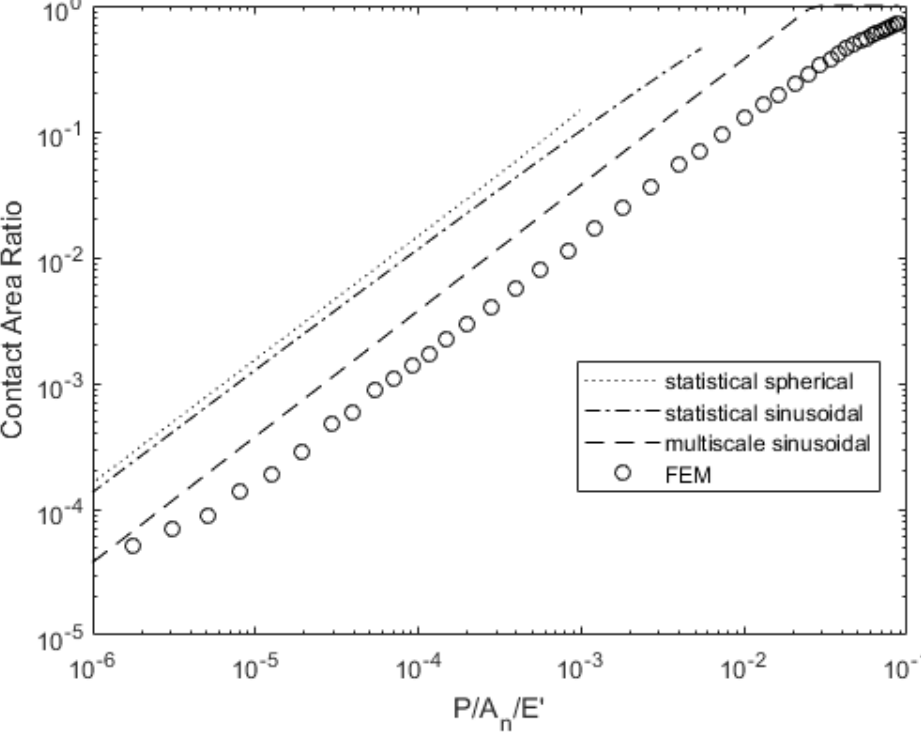
Figure 12. Load-dependent contact area variation for surface 63M.